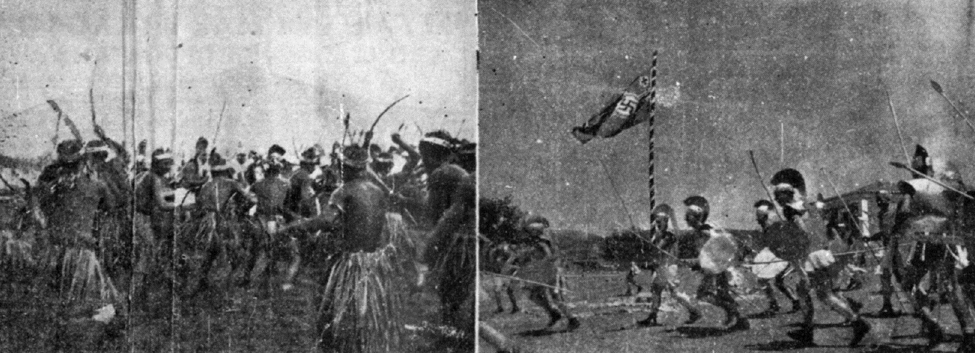
Figure 1. Nazi soldiers in Thermopylae, Greece, re-enacting the eponymous battle in 1941 [source: ( I Vradyni 1941), The Library of the Hellenic Parliament].